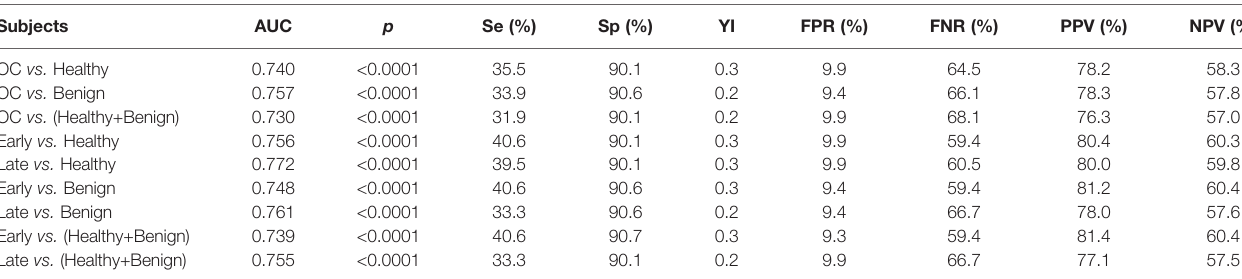
TABLE 3 | Diagnostic value of anti-PDLIM1 AAb to OC.